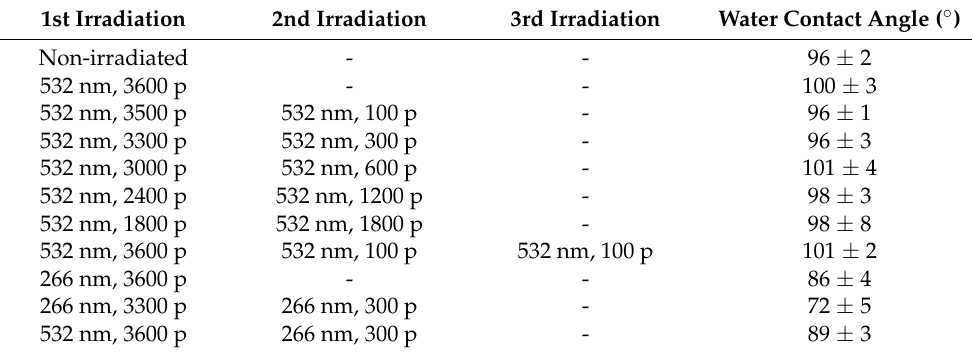
Table 1. Water contact angle of nanostructured P3HT.